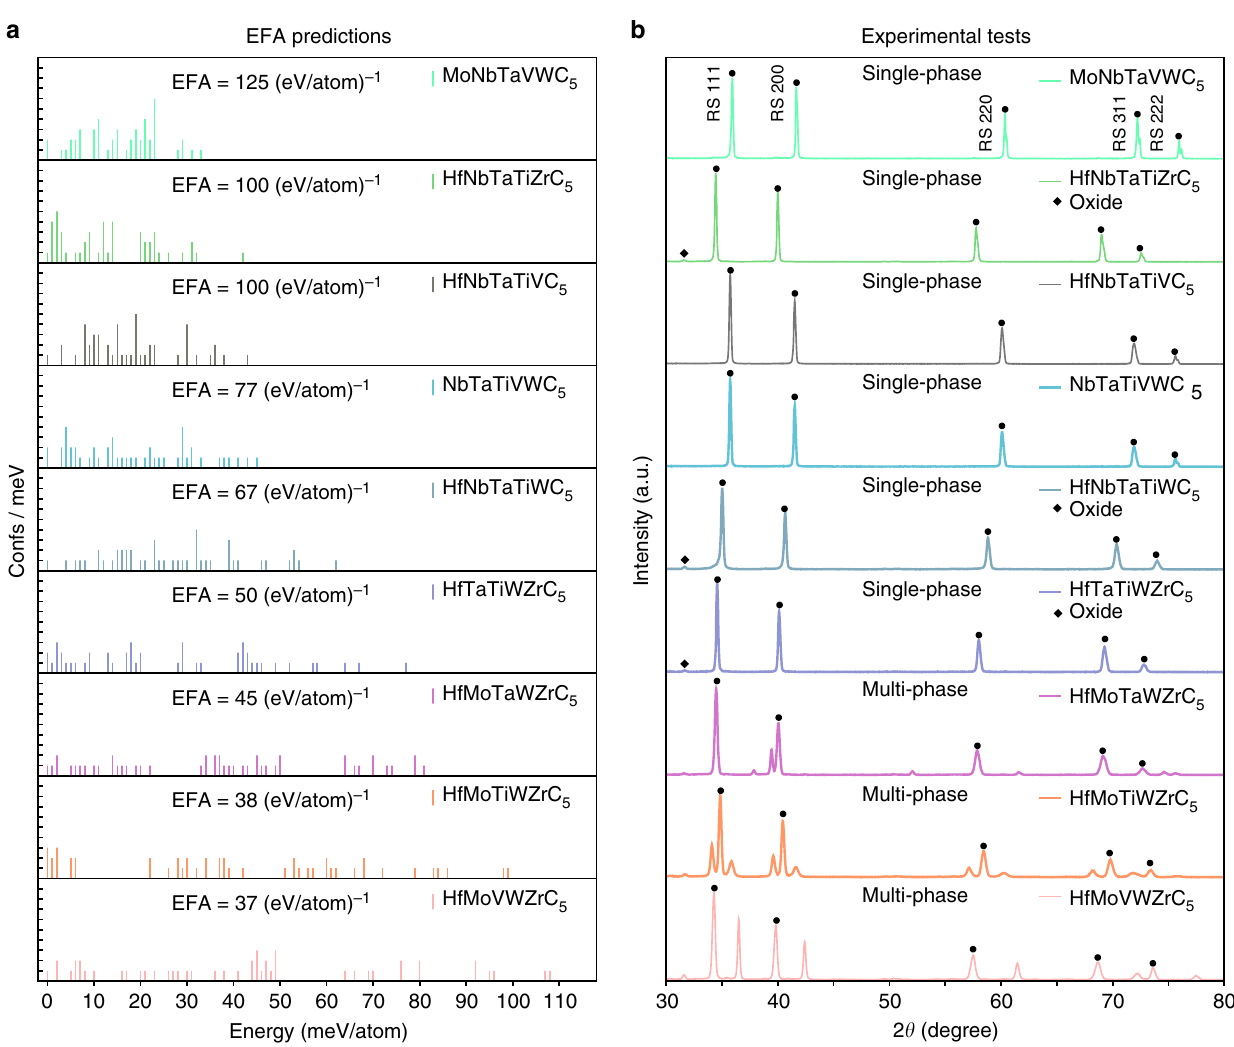
Fig. 1 Schematics of high-entropy carbides predictions. a The energy distribution of different con fi gurations of the 9 fi ve-metal carbides: MoNbTaVWC 5 , HfNbTaTiZrC 5 , HfNbTaTiVC 5 , NbTaTiVWC 5 , HfNbTaTiWC 5 , HfTaTiWZrC 5 , HfMoTaWZrC 5 , HfMoTiWZrC 5 , and HfMoVWZrC 5 ; spectrum is shifted so that the lowest energy con fi guration for each composition is at zero. The energy spectrum for each composition indicates its propensity to form the high-entropy single phase: the narrower the distribution, the more likely it is to form a high-entropy single phase at fi nite T . b The X-ray diffraction patterns for the same 9 fi ve-metal carbides, where the fi rst six compositions exhibit only the desired fcc structure peaks, whereas the additional peaks for remaining three compositions indicate the presence of secondary phases. The small peaks at 2 θ = 31.7°, marked by the diamond symbol in the spectra of HfNbTaTiZrC 5 , HfNbTaTiWC 5 and HfTaTiWZrC 5 , are from the (111) plane of a monoclinic (Hf,Zr)O 2 phase that remains due to